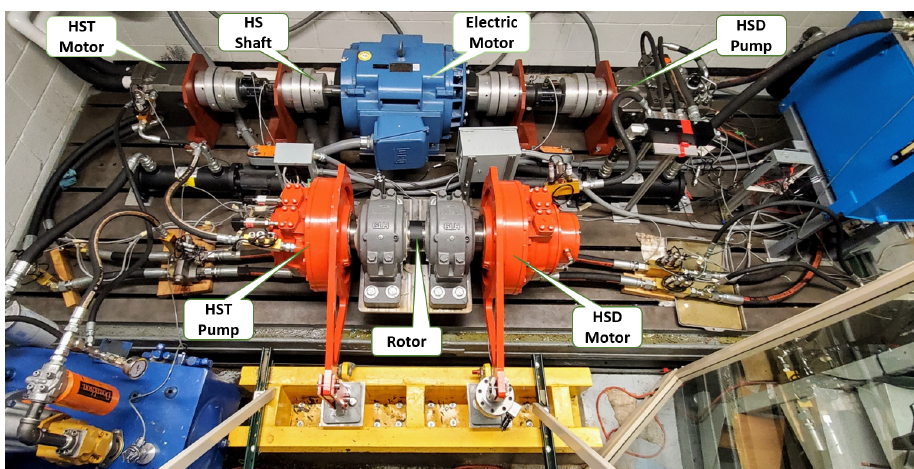
Figure 3. A power-regenerative hydrostatic dynamometer developed at the University of Minnesota. The energy conversion occurs from mechanical to hydraulic and then back to mechan- ical in the HSD and HST. A unified bond graph model of the dynamometer is shown in Figure 4 [17]. The energy storage elements; the inertia in the mechanical system, I 1 and I 2 ; and fluid capacitance, C 3 and C 4 , are shown in red. The mechanical and hydraulic losses are modeled as R elements. Three control inputs are shown in red boxes. The power flows between HSD and HST in the clockwise direction. The losses in energy conversion in the HSD and HST are replenished by electrical input.